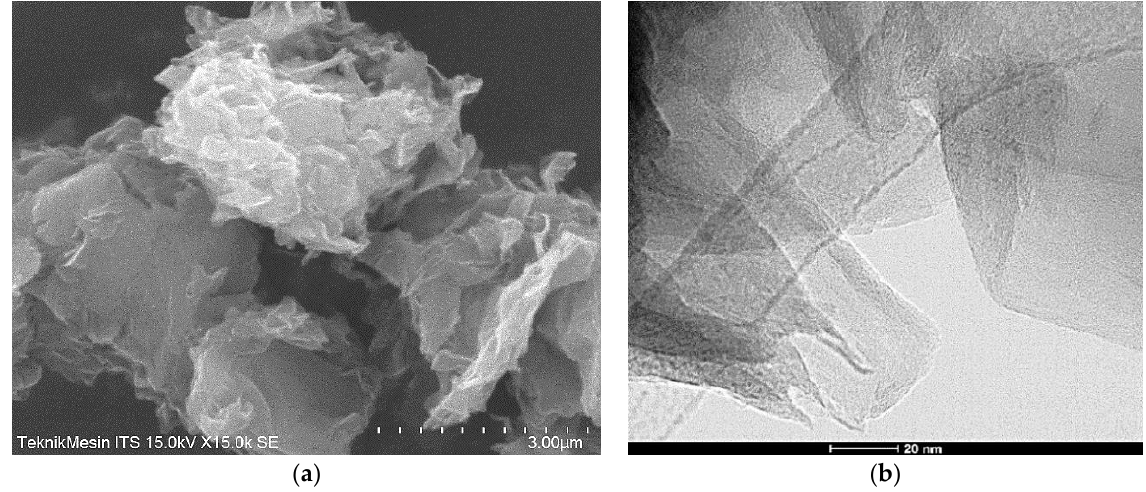
Figure 6. ( a ) SEM image, and ( b ) TEM image of rGO. The images show that the rGO surface reveals crumpled thin layers.